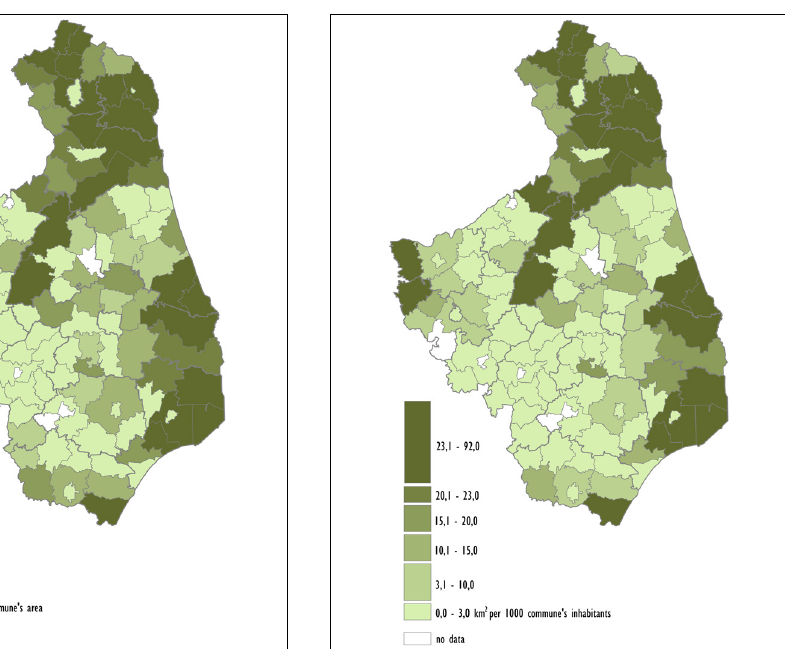
Fig. 7. Percentage of a legally protected area Fig. 8. The legally protected